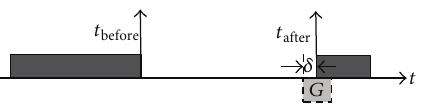
Figure 8: No downstream transmission between two upstream transmissions.